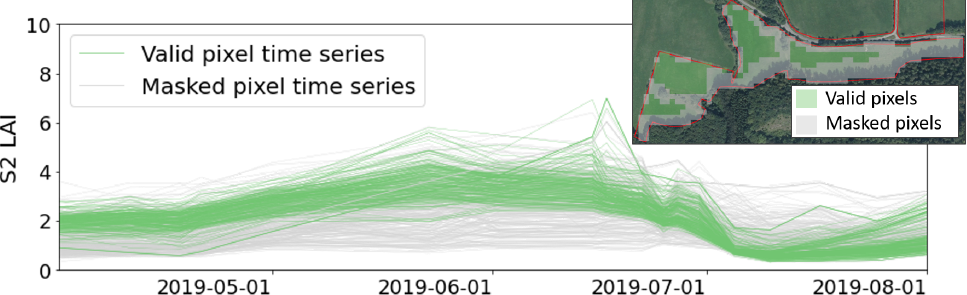
Figure 5. Leaf Area Index (LAI) time series (retrieved from Sentinel-2) extracted per valid (green) and masked (gray) pixel for a grassland parcel (drawn in red on the orthophoto